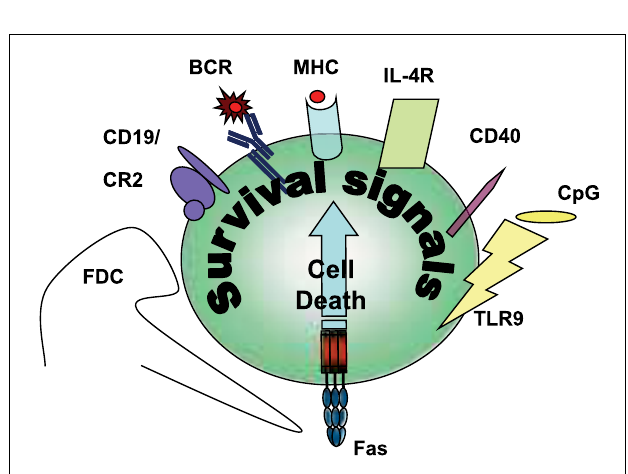
FIGURE 1 | Four different types ofT cell–B cell interaction can occur in the germinal center: (A) following antigen recognition the specific B cells express Fas and in time became capable of presenting antigen to antigen-specificT cells. Strong affinity B cells maintain their antigen specificity during somatic mutation and as a consequence the BCR transduces signals even during competition for the limited available antigen. The BCR-mediated survival signals compete with Fas-induced cell death. (B) The naive (bystander) B cells do not interact with activated, FasL-expressingT cells in the absence of presentation of the appropriate antigen. In this situation their Fas expression is also very limited. As mentioned above, these